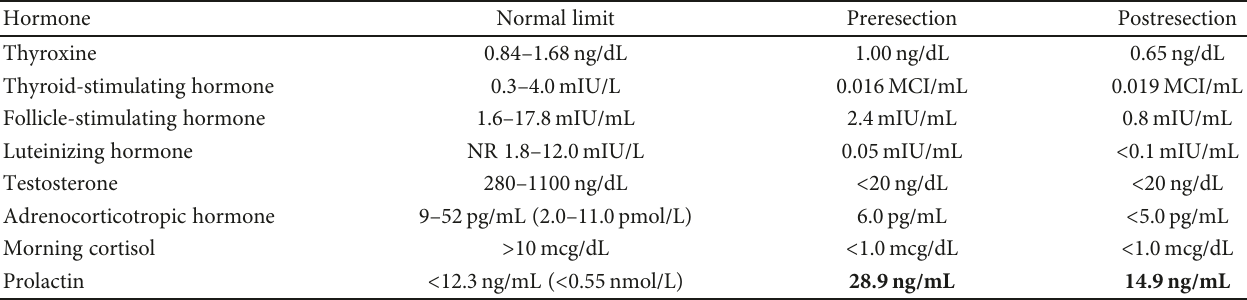
Table 1: Laboratory results before and after transsphenoidal pituitary metastases